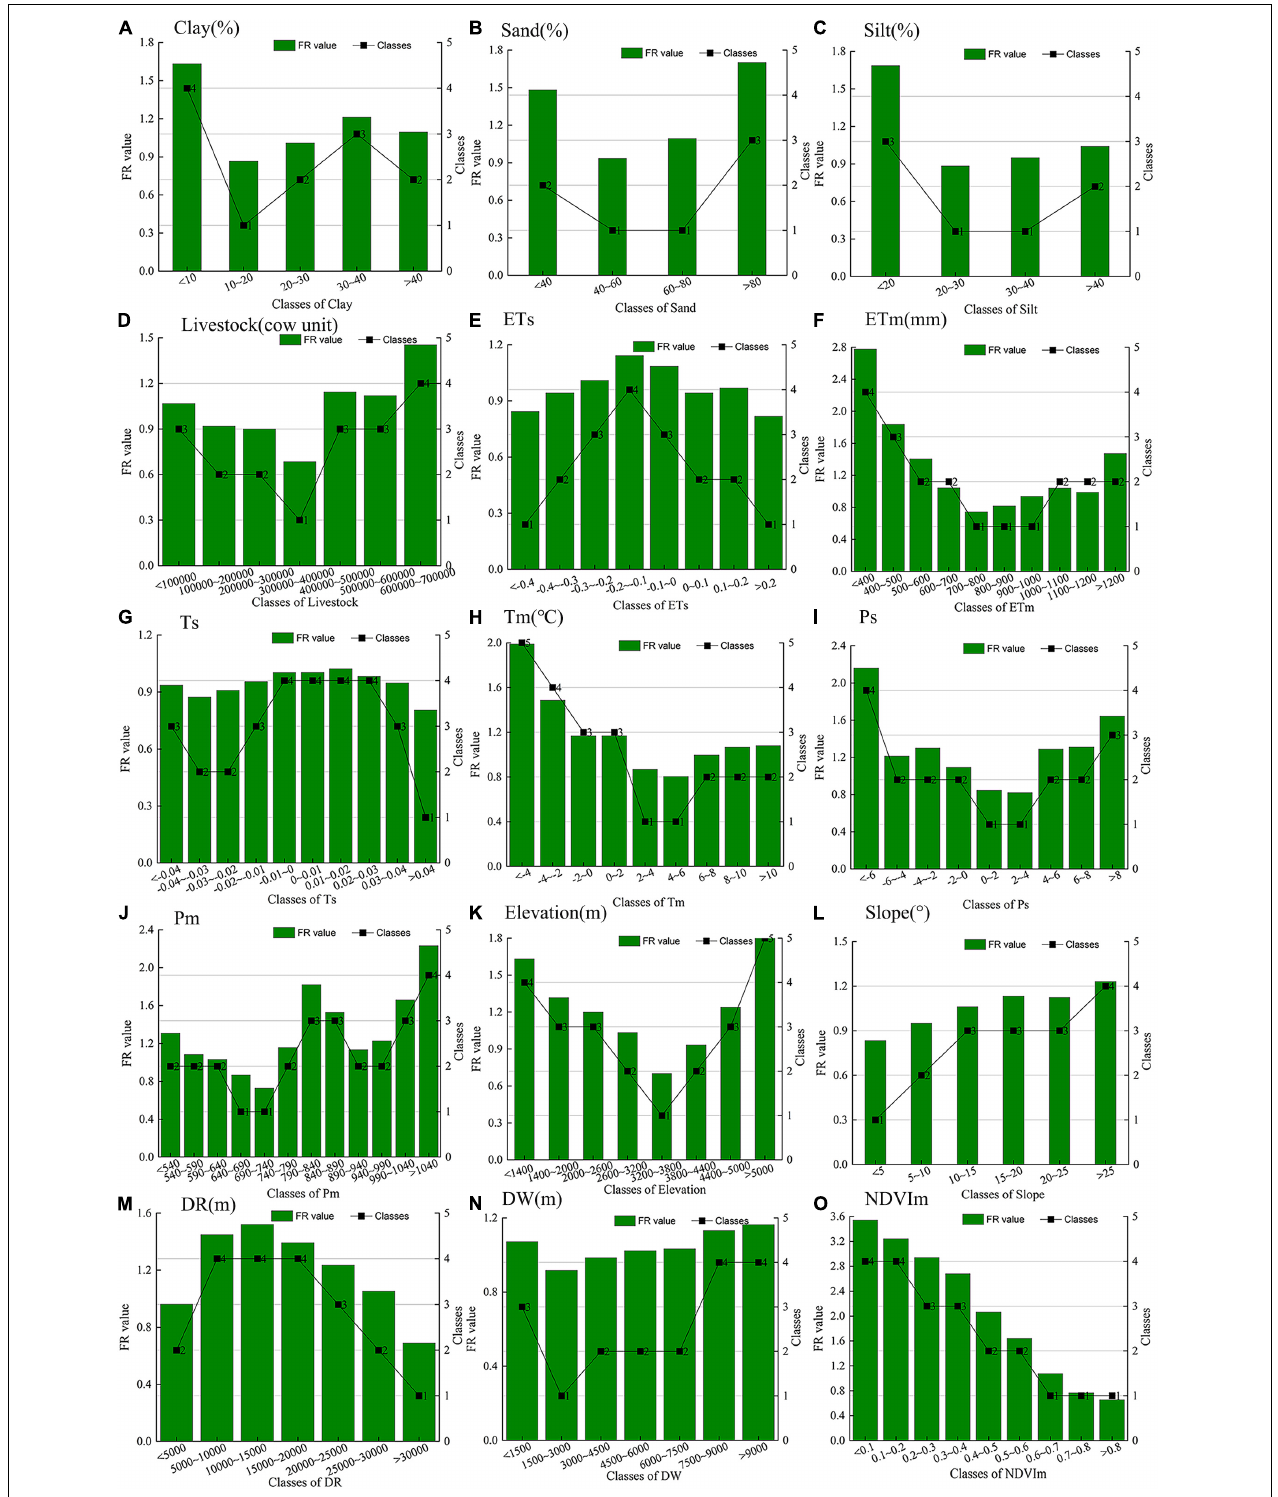
FIGURE 6 | Relationship between the grass degradation and the conditioning factors. (A) Clay. Proportion of clay. (B) Sand (%). Proportion of sand. (C) Silt (%). Proportion of silt. (D) Lm (cow unit). Mean value of the number of livestock. (E) Ts. Slope of annual temperature change. (F) Tm ( ◦ C). Mean value of annual temperature. (G) ETs. Slope of annual potential evapotranspiration change. (H) ETm (mm). Mean value of annual potential evapotranspiration. (I) Ps. Slope of annual precipitation. (J) Pm (mm). Mean value of annual precipitation. (K) DEM (m). Elevation. (L) Slope ( ◦ ). Slope. (M) DR (m). The distance between each grid and its nearest road. (N) DW ( ◦ ). The distance between each grid and its nearest water body. (O) NDVIm. Mean value of annual normalized difference vegetation index.